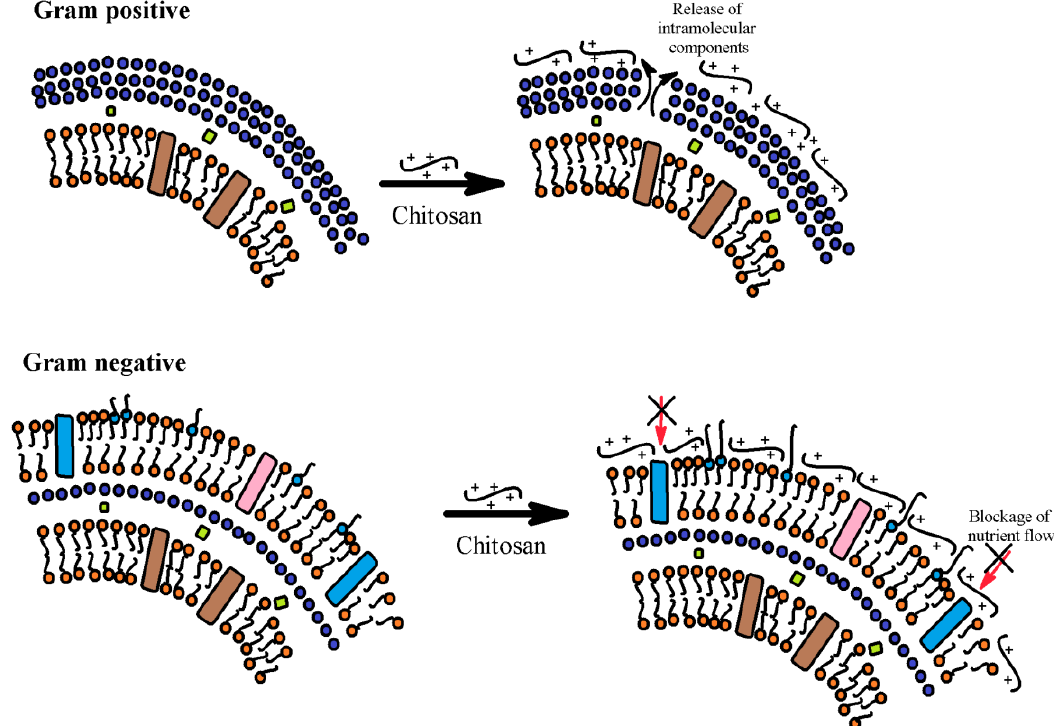
Figure 11. Action modes of chitosan on Gram positive and Gram negative bacteria. Structural composition of the outer envelope of Gram positive and Gram negative bacteria and effect of chitosan binding to the outer envelope of Gram positive and Gram negative bacteria.